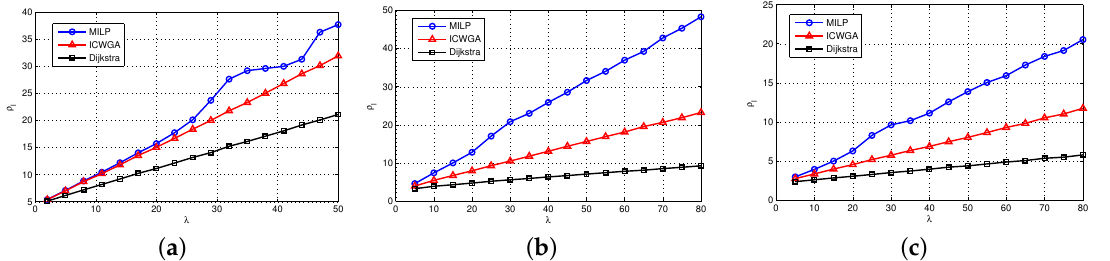
Figure 4. The results for average bandwidth utilization of different SND-Lib topologies. ( a ) Abilene. ( b ) India. ( c )